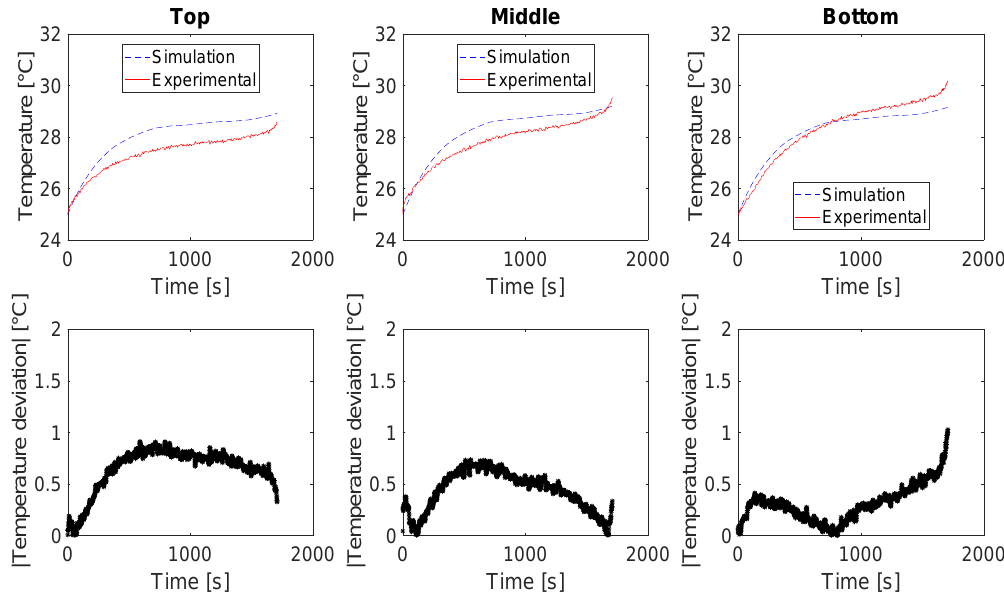
Figure 20. ( Upper ) Uncycled cell surface temperature at three different locations (Top, Middle, Bottom) during high constant current discharge at 25 ◦ C room temperature; ( Lower ) Corresponding absolute values of the temperature deviation between experimental and simulations